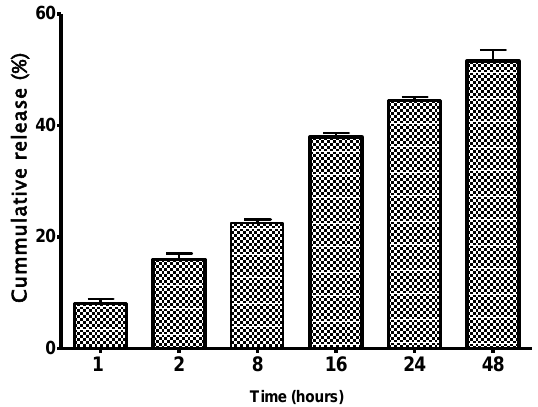
Figure 5. In vitro release of rOmpA protein from encapsulated NPs. Note the exponential increase in rOmpA release within 24 h of the start of the in vitro test.